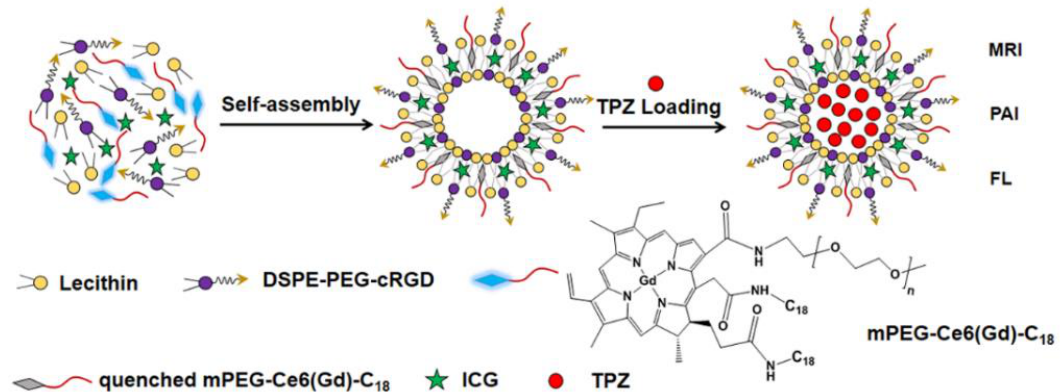
Figure 11. Formation of liposomes loaded with mPEG-Ce6-C 18 . Reprinted with permission from [145]. Copyright 2019 American Chemical Society.